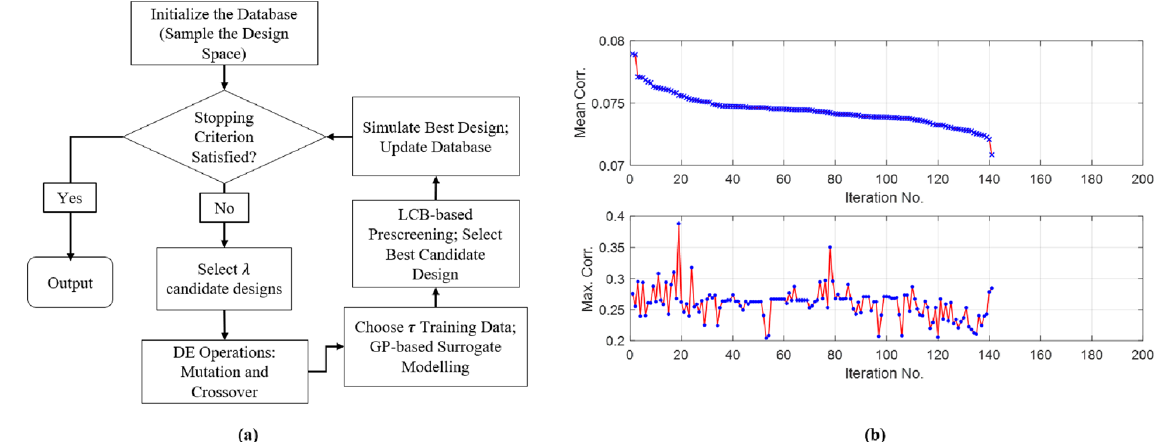
Figure 6. ( a ) Flow diagram of SADEA-I. ( b ) Comparison between mean and maximum correlation coefficients when mean correlation coefficient against each iteration is plotted in descending order.